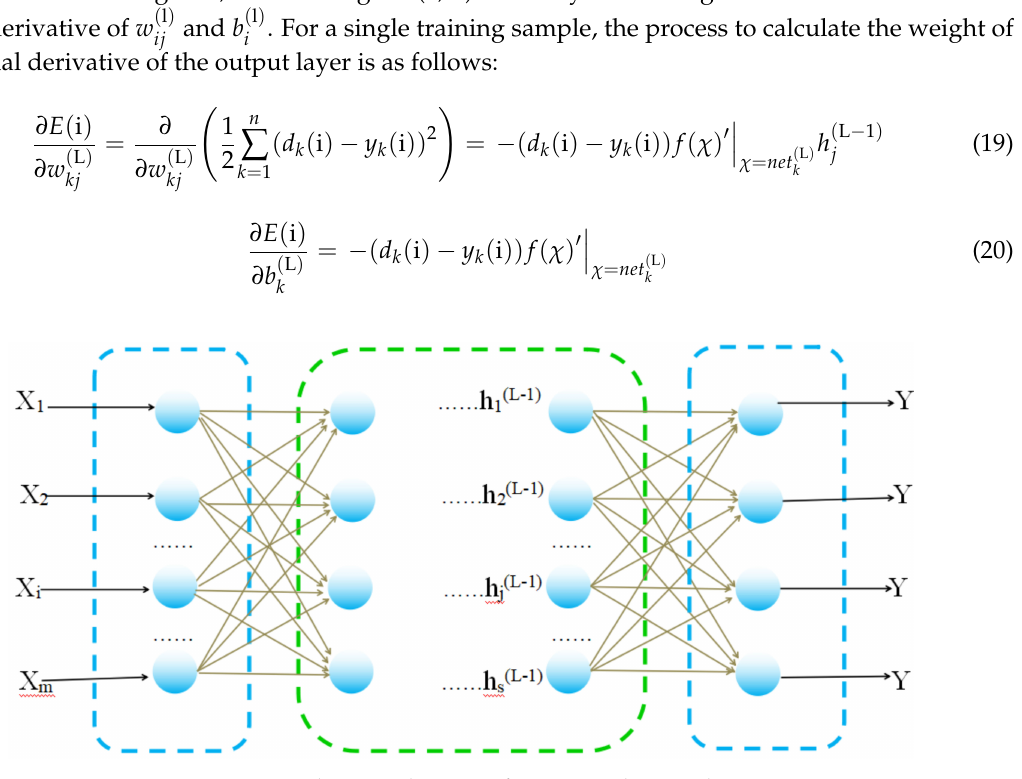
Figure 4. Schematic diagram of a BP neural